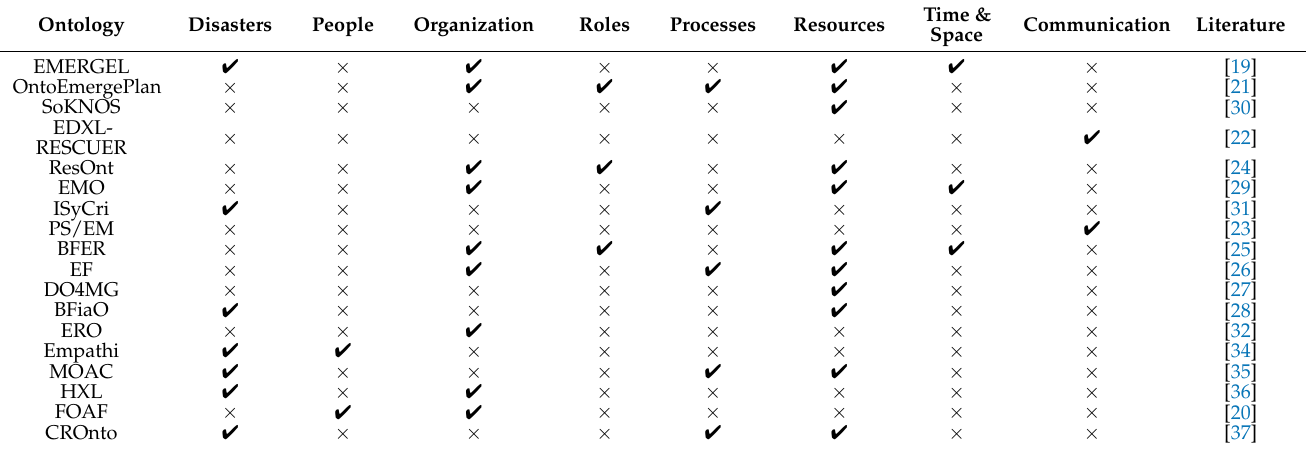
Table 1. Comparative study of existing disaster management